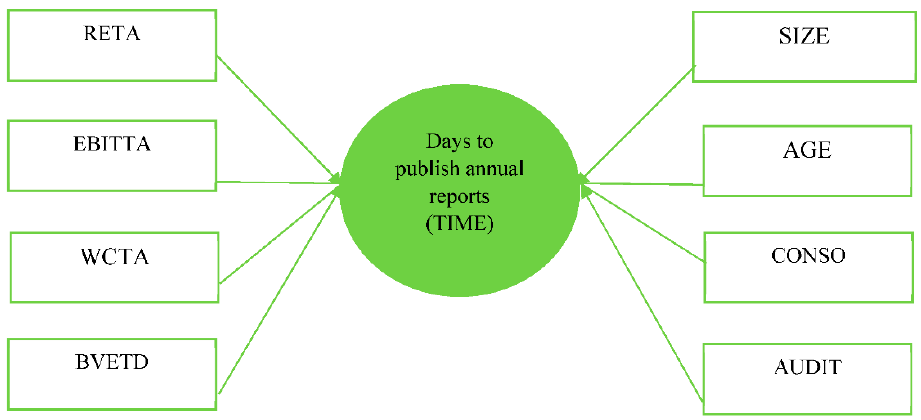
Figure 1. Research model of determinants of time for pubication annal reports (source: proposed by the authors).